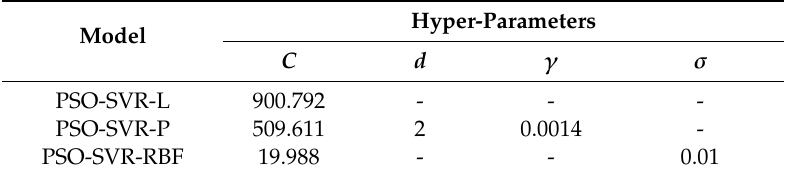
Table 4. The parameters of the PSO-SVR models for estimating PM 10 concentration.